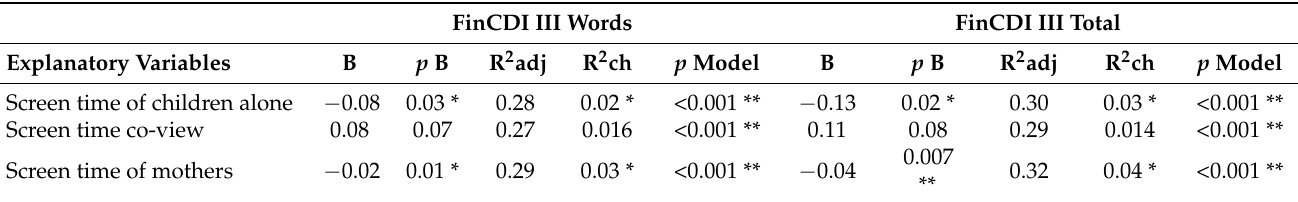
Table 4. Results of linear regression